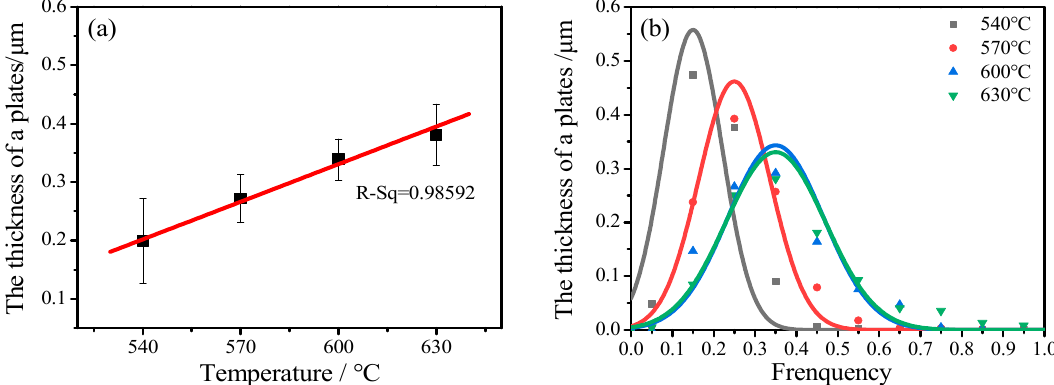
Figure5. Thevariationanddistributionofthelamellar α afterthermomechanicaltreatment: ( a )variation; Figure 5. The variation and distribution of the lamellar α after thermomechanical treatment: ( a ) ( b ) variation; ( b ) distribution.